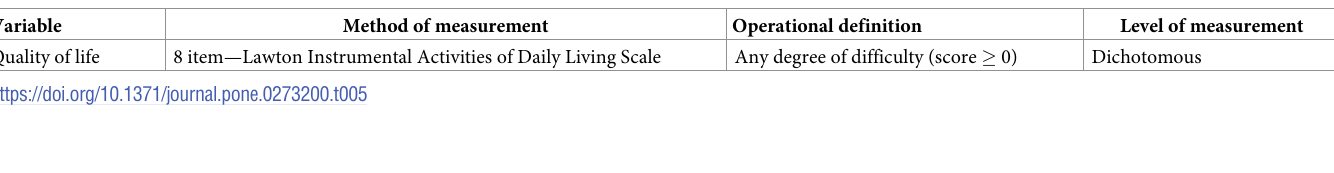
Table 5. Summary and description of objective number 5 variables of the